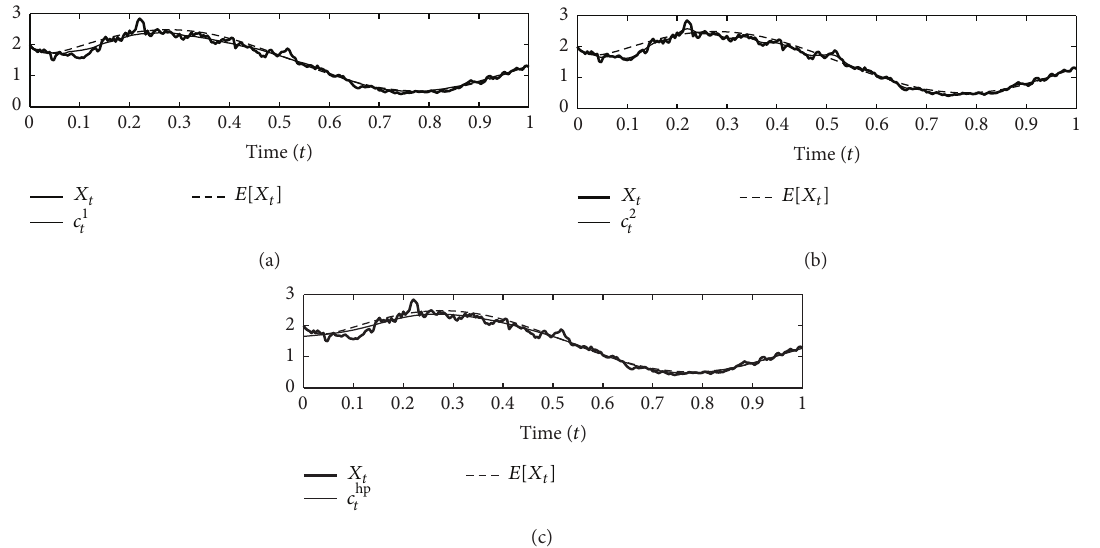
Figure 2: Dynamic behavior for process 𝑋 𝑡 , the expected value 𝑚(𝑡) , and three types of convolution. (a) Moving average (𝑐 1 𝑡 ) with 𝑁 = 20 . (b) Pascal’s weights (𝑐 2 𝑡 ) with 𝑁 = 20 . (c) Hodrick-Prescott filter (𝑐 hp 𝑡 ) with 𝜆 hp = 40000 . For all the cases Δ𝑡 = 1/250 for a total of 250 observations and the parameters of 𝑋 𝑡 are the same as in Figure